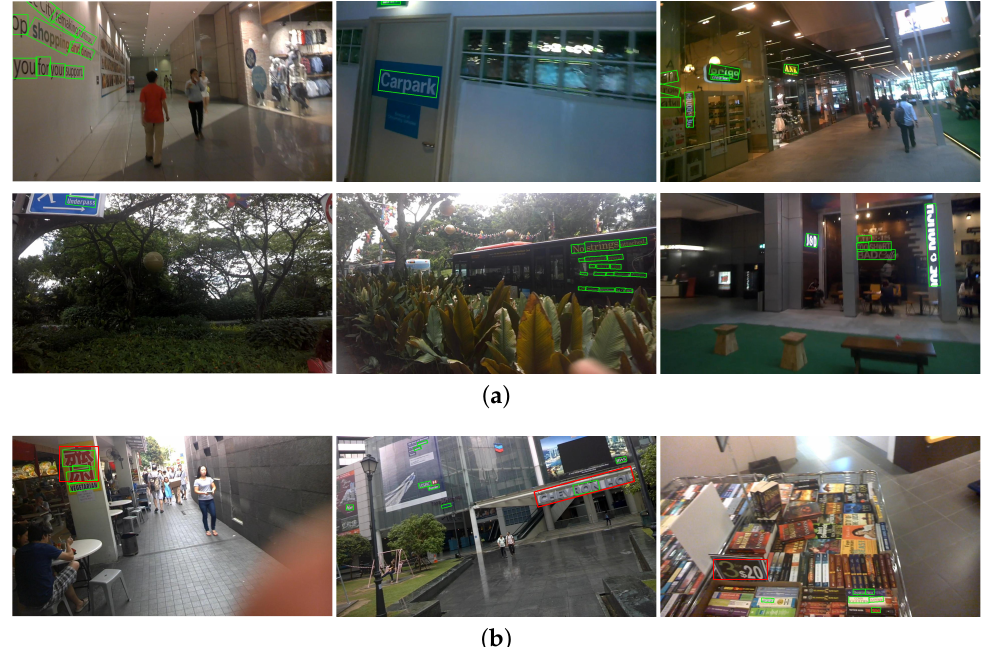
Figure 6. Results on ICDAR2015. The green boxes in ( a , b ) and the red boxes in ( b ) represent the evaluation results of the text and the error detection boxes of them,